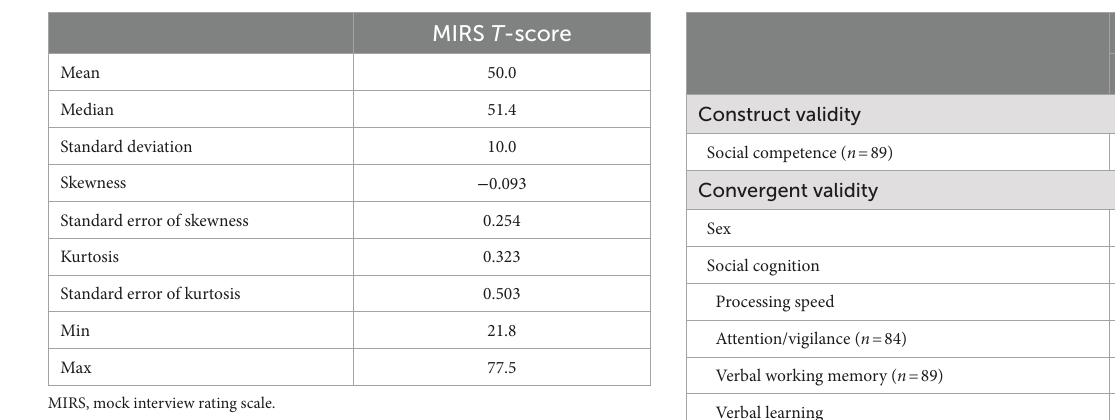
TABLE 4 MIRS T -score descriptive statistics ( n = 90). TABLE 5 Validity correlations ( n =